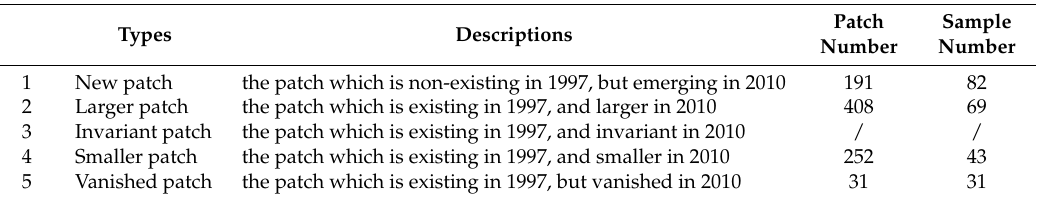
Table 1. Evolution types of rural settlements.